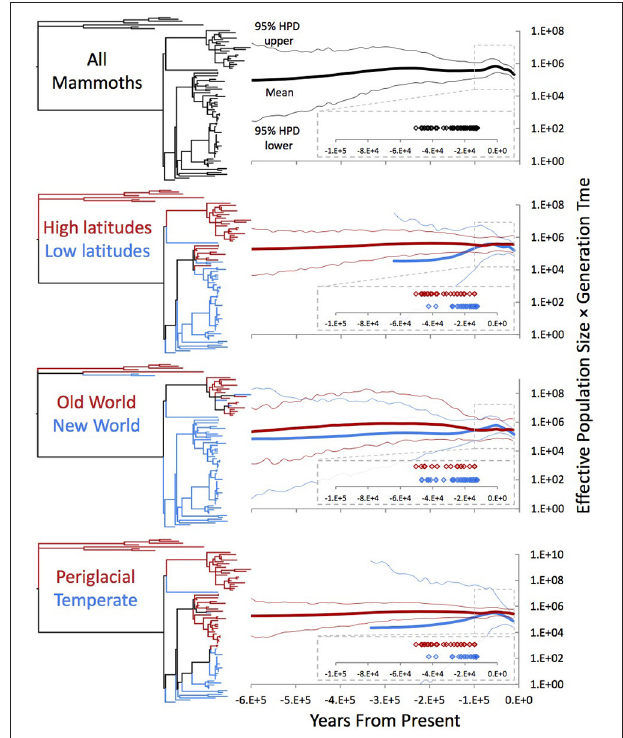
FIGURE 4 | Bayesian Skygrid analyses of the whole dataset and under three partition schemes. Each projection was estimated in BEAST using the partition-specific best model indicated by the AICc in jModelTest. Trees adjacent to each Skygrid are color-coded by which specimens were included in the individual projections. “High”-latitude samples are those from the Old World and Alaska and the Yukon, while “low”-latitude samples are those from the Great Lakes, east coast, Great Plains, mountain west, and west coast. “Periglacial” samples are those in high latitudes as well as the Great Lakes and east coast, contexts near the Laurentide ice sheet during the Late Pleistocene, while “temperate” specimens are the rest. All Skygrid population sizes are associated with posterior effective sample sizes >